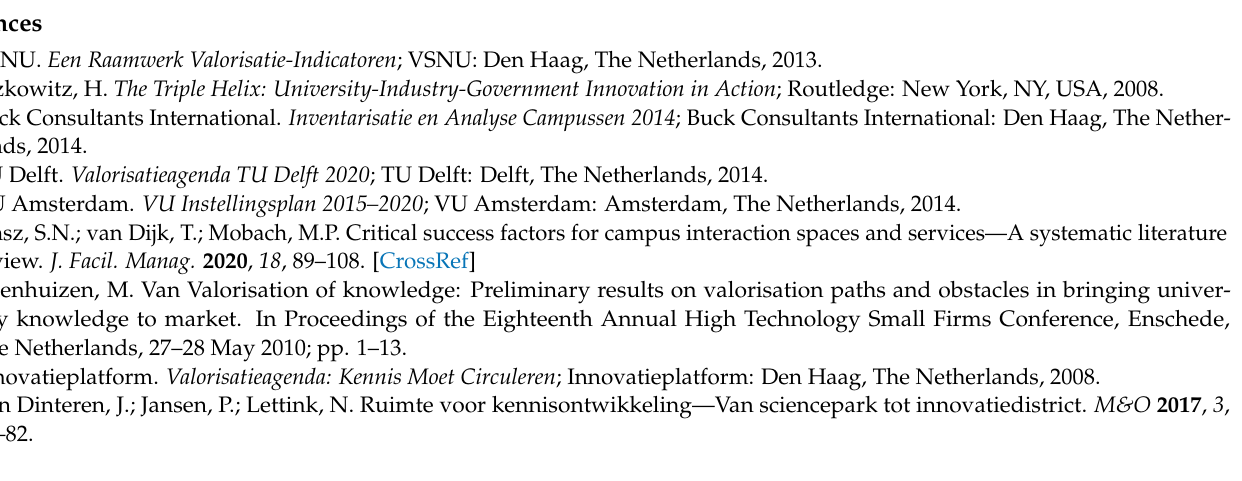
Figure A14. Locations—overview Likert scores. StD = strongly disagree, D = disagree, SD = slightly disagree, N = neutral, SA = slightly agree, A = agree, StA = strongly agree.